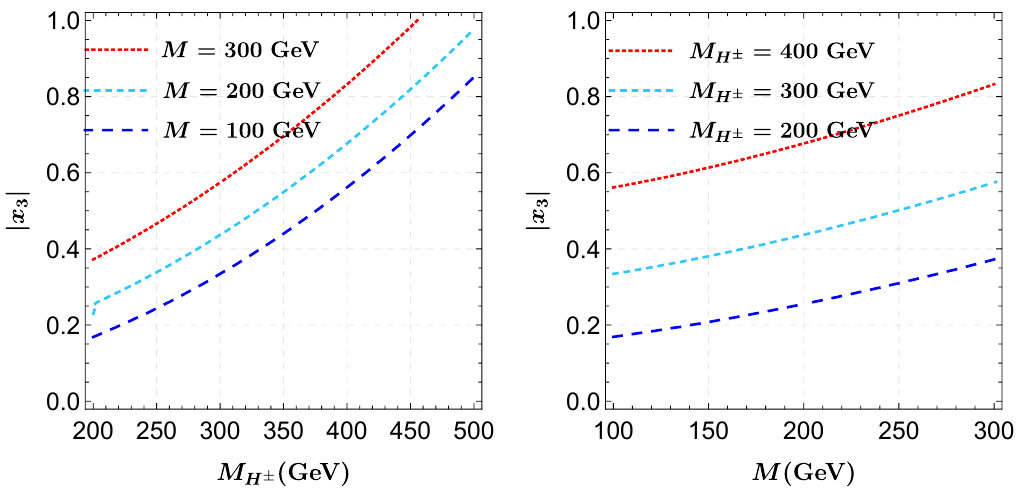
; j x 3 j ) contours H (cid:6)